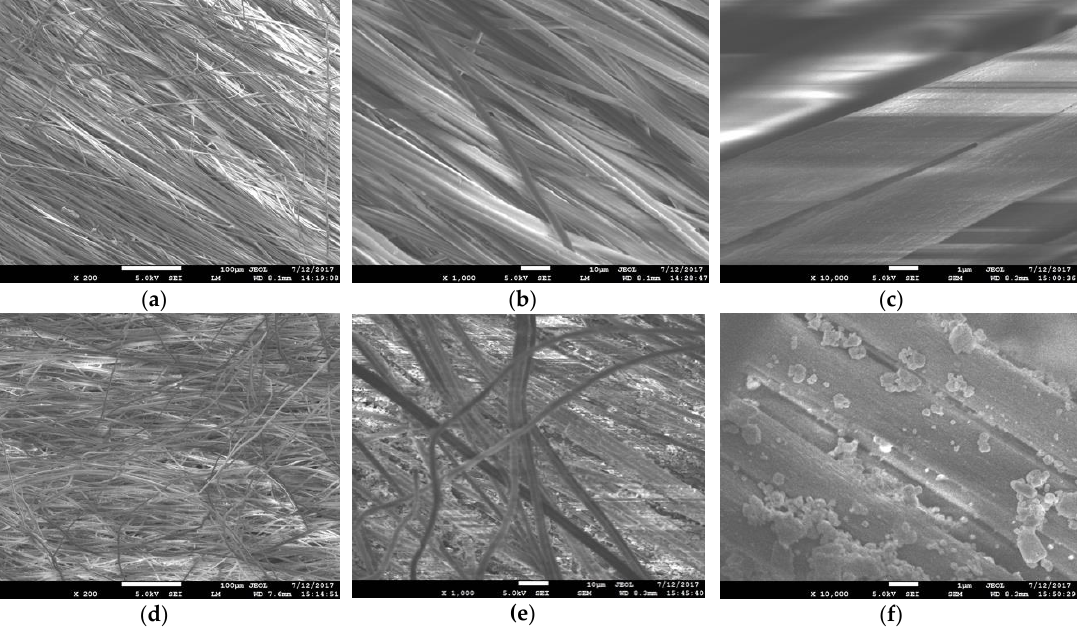
Figure 2. Scanning electron micrographs (SEM) of electrospun PAN fibres: ( a ) PAN at × 200 magnification (Scale Bar = 100 µ m); ( b ) PAN at × 1000 magnification (Scale Bar = 10 µ m); ( c ) PAN at × 10,000 magnification (Scale Bar = 1 µ m); ( d ) PAN–AgNP (silver nanoparticles) at × 200 magnification (Scale Bar = 100 µ m); ( e ) PAN–AgNP at × 1000 magnification (Scale Bar = 10 µ m); ( f ) PAN–AgNP at × 10,000 magnification (Scale Bar = 1 µ